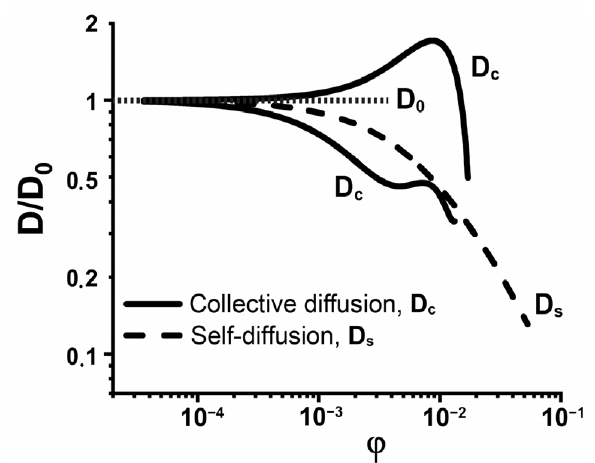
Figure 2. Schematic representation of protein concentration dependence of collective ( D c ) and self- diffusion ( D s ) coefficients, D c in the cases of the repulsive and attractive inter-molecular interactions, D 0 is diffusion coefficient in dilute solution. The original data were obtained from [52].